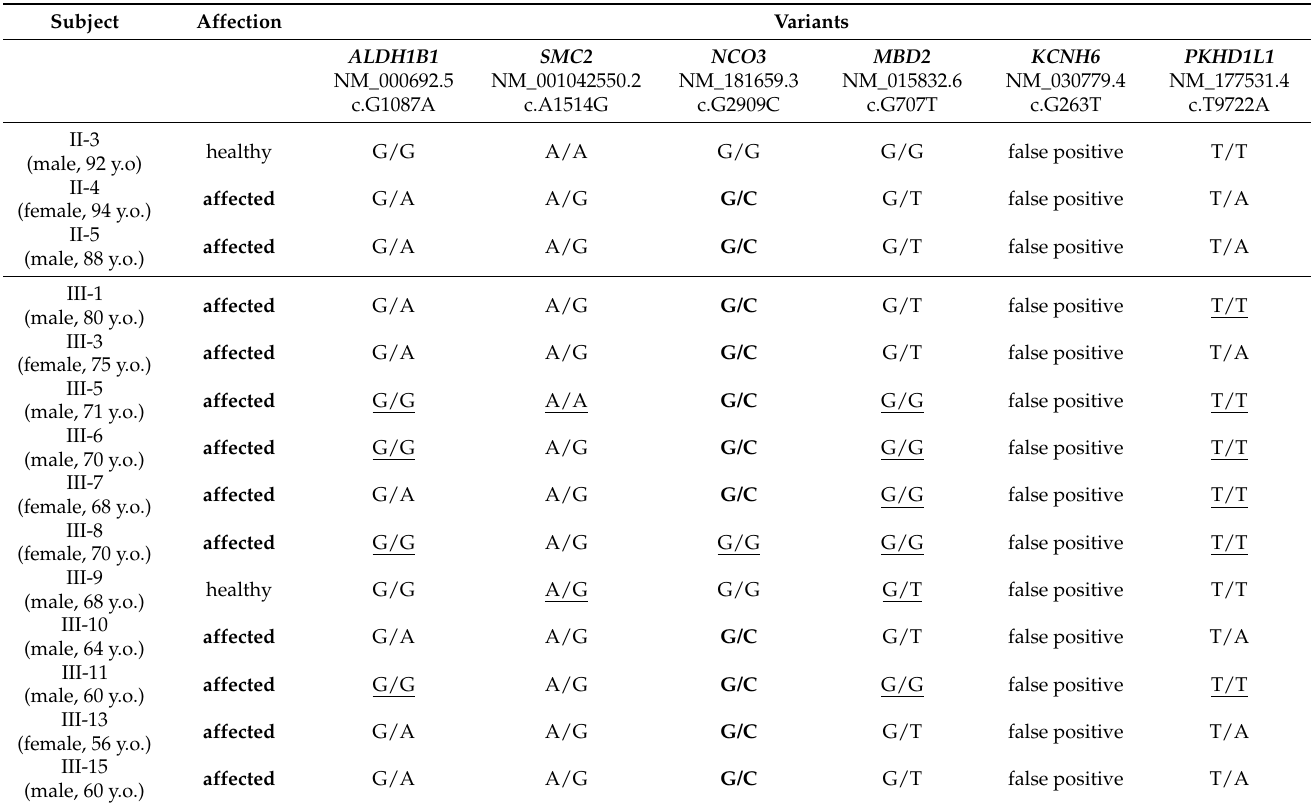
Table 2. Genotype–phenotype associations. Co-segregation of the six variants with HL in the fourteen members of the family for whom ES was performed. Each patient’s age and gender are indicated. The underlined genotypes are not consistent with the phenotypes of the patients, while the ones reported in bold highlight the segregation of the most interesting variant (NM_181659.3, c.2909G>C, p.(Gly970Ala), rs765371222) in the affected